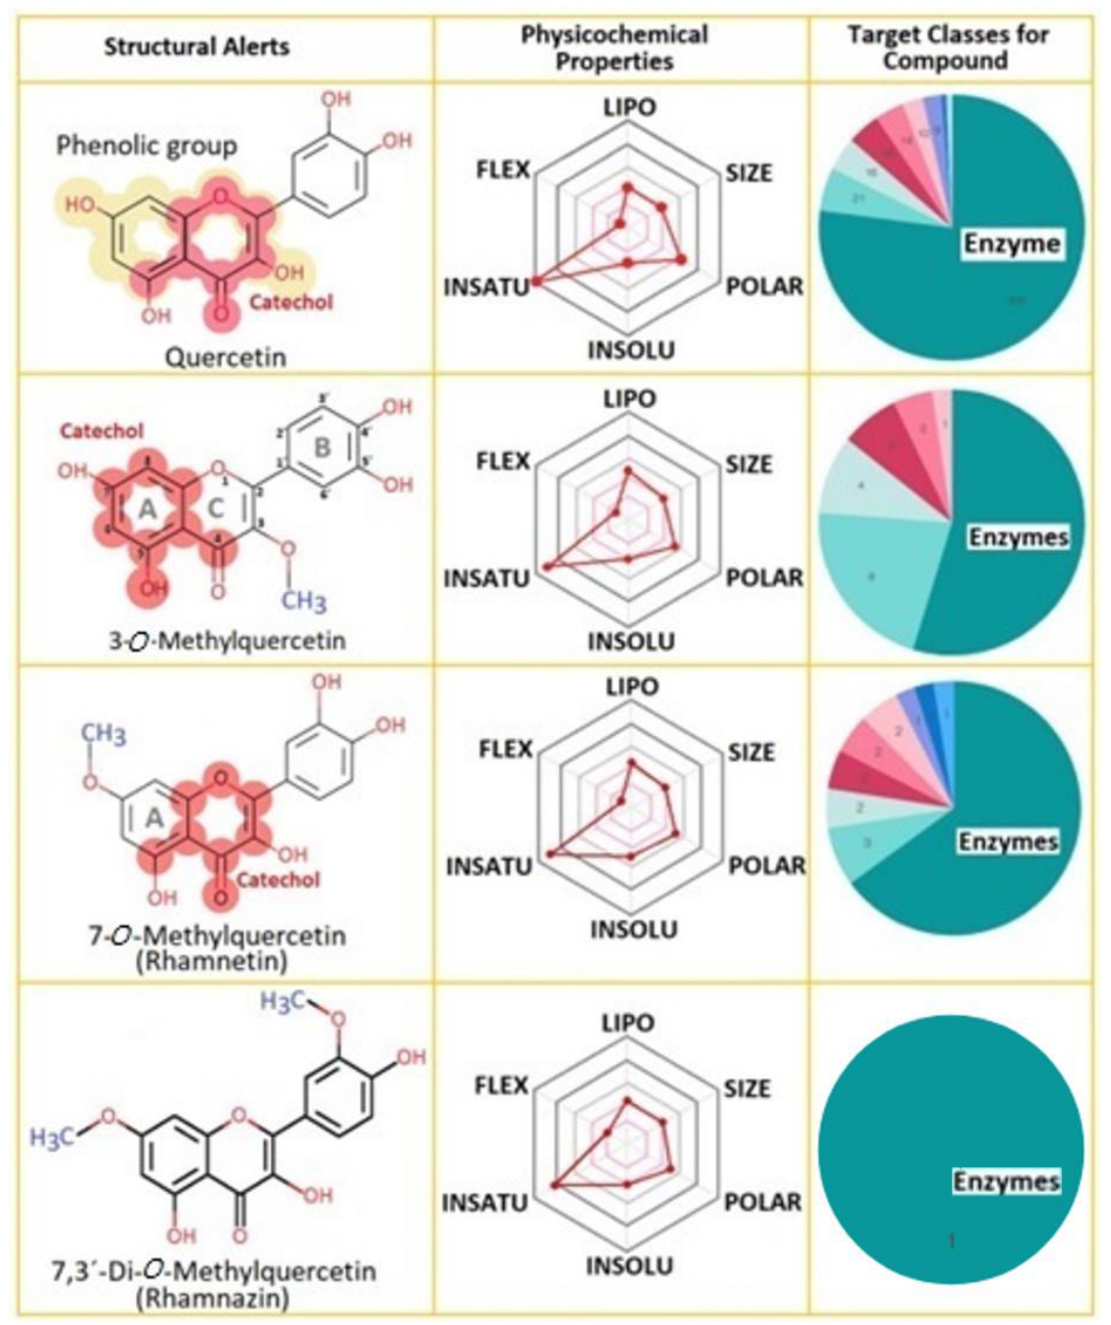
Figure 1. Structural alerts, physicochemical properties of possible targets of Q, Rhm, 3MQ and Rhz. Physicochemical properties in the second column are abbreviated and mean: Lipo: lipophilicity, Flex: Flexibility, Insatu: Insaturations, Insolu: insolubility, Polar: Polarity.